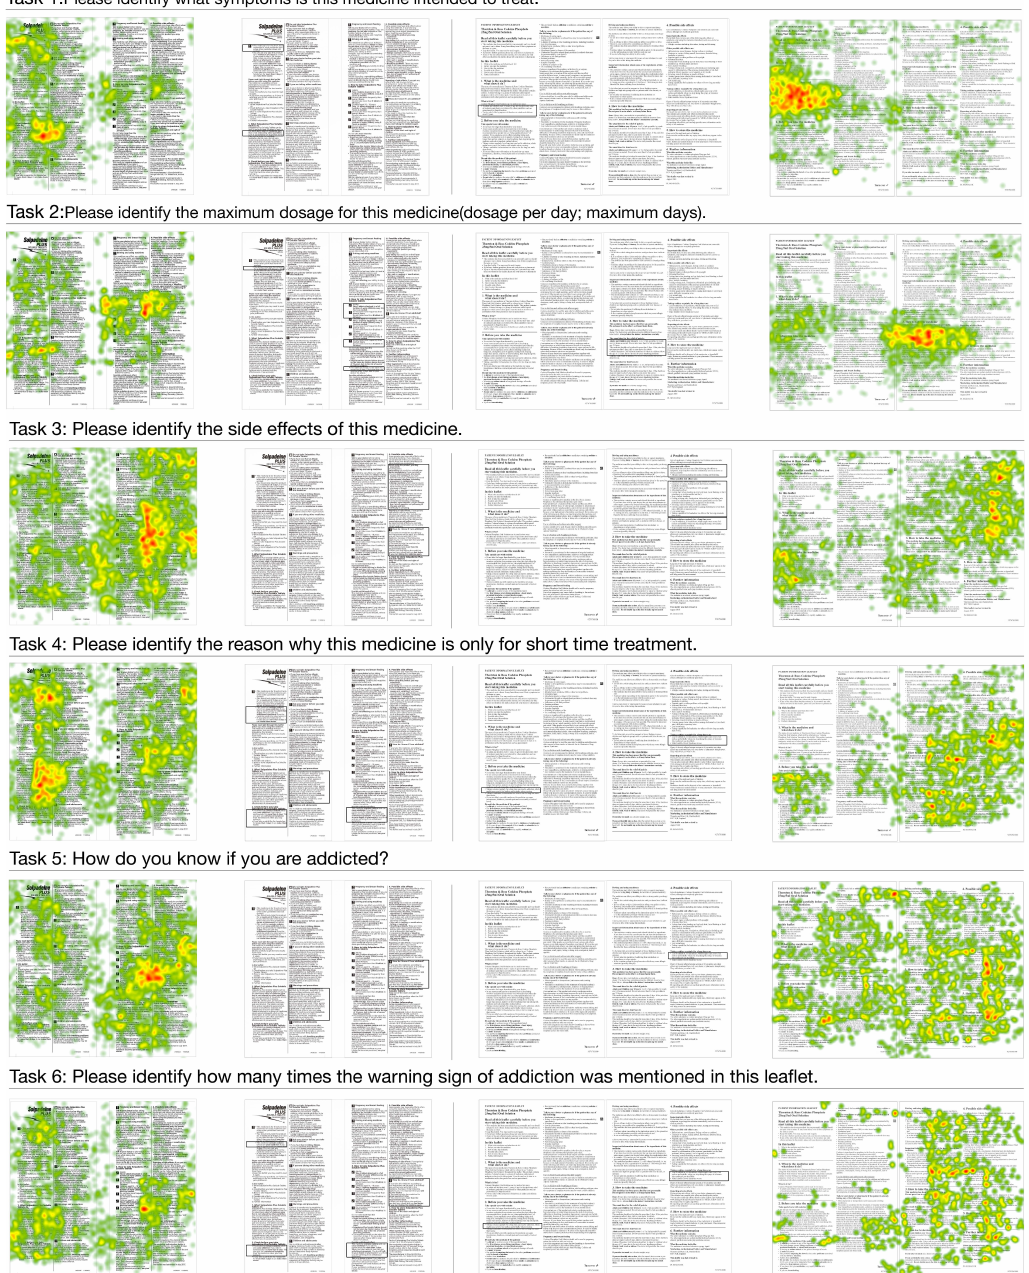
Figure 5. Field of view: the result of the eye-tracking experiment (shown by heat-map images); the left side is Sample 1 and the right side is Sample 2. The correct answers for each task are boxed in the